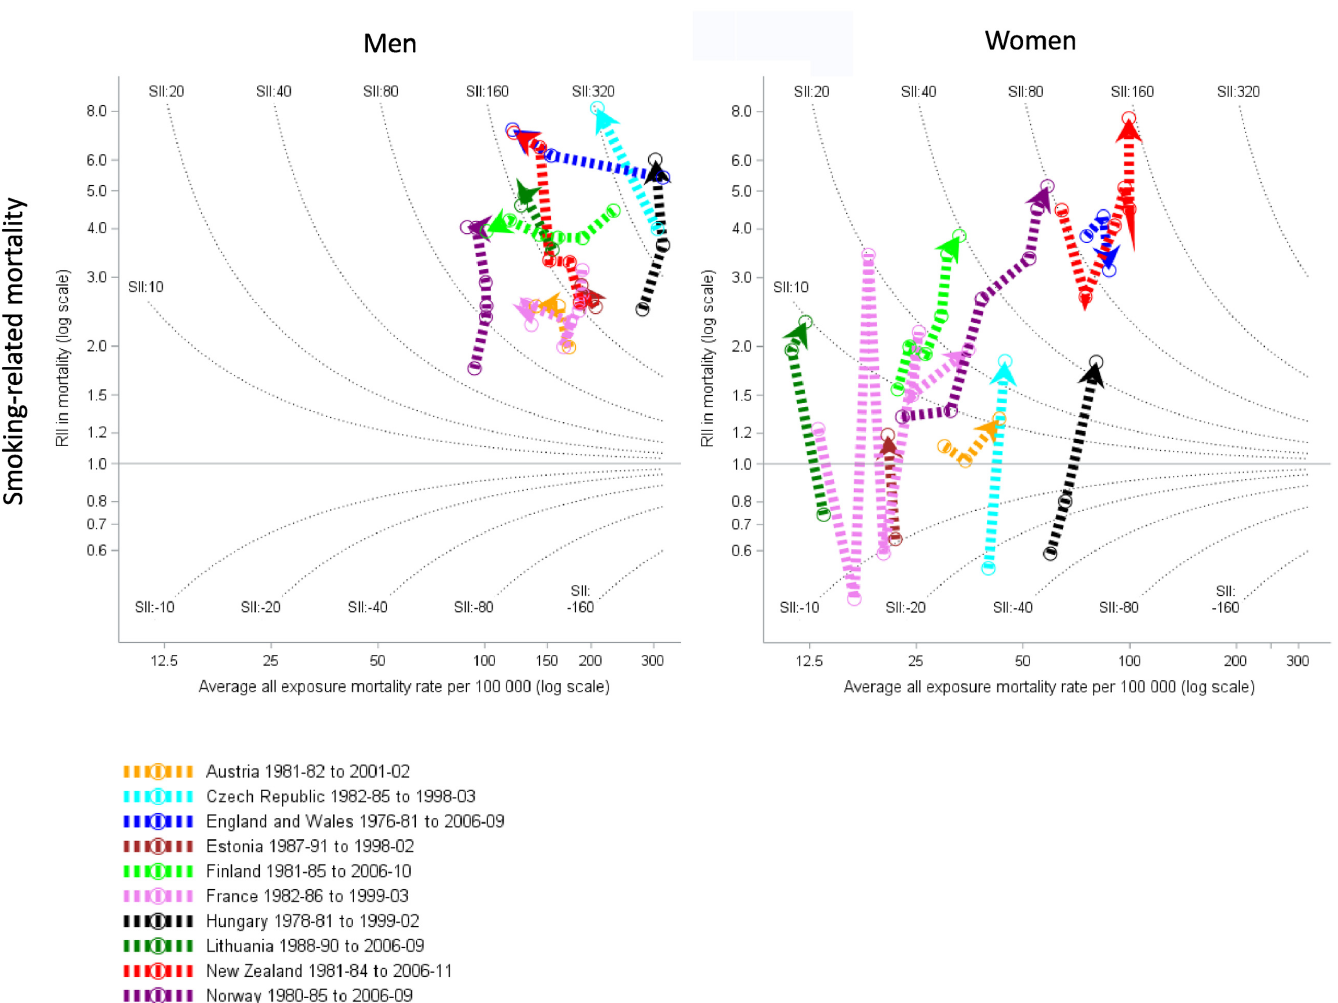
Fig 2. Trends and education inequalities in smoking-related mortality (lung cancer, COPD and laryngeal cancer), 1980–2010. Relative inequalities are measured by relative index of inequality (RII) on the log scale, and absolute inequalities by the slope index of inequality (SII) indicated by the contour lines.